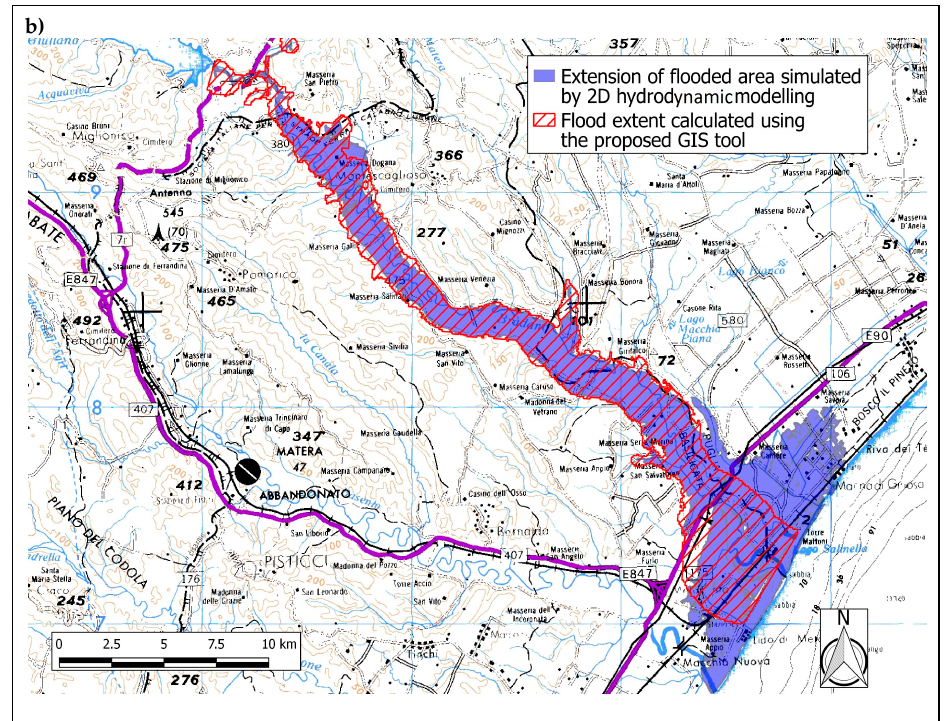
Figure 11. ( a ) Comparison of the flooded area estimated by the proposed GIS tool for the San Giuliano potential dam-break with the flooded area calculated by Sole et al., 1997 [33]; ( b ) Comparison of the flooded area estimated by the proposed GIS tool for the San Giuliano potential dam-break with the flooded area calculated by the 2D hydrodynamic model proposed by Cantisani et al., 2013